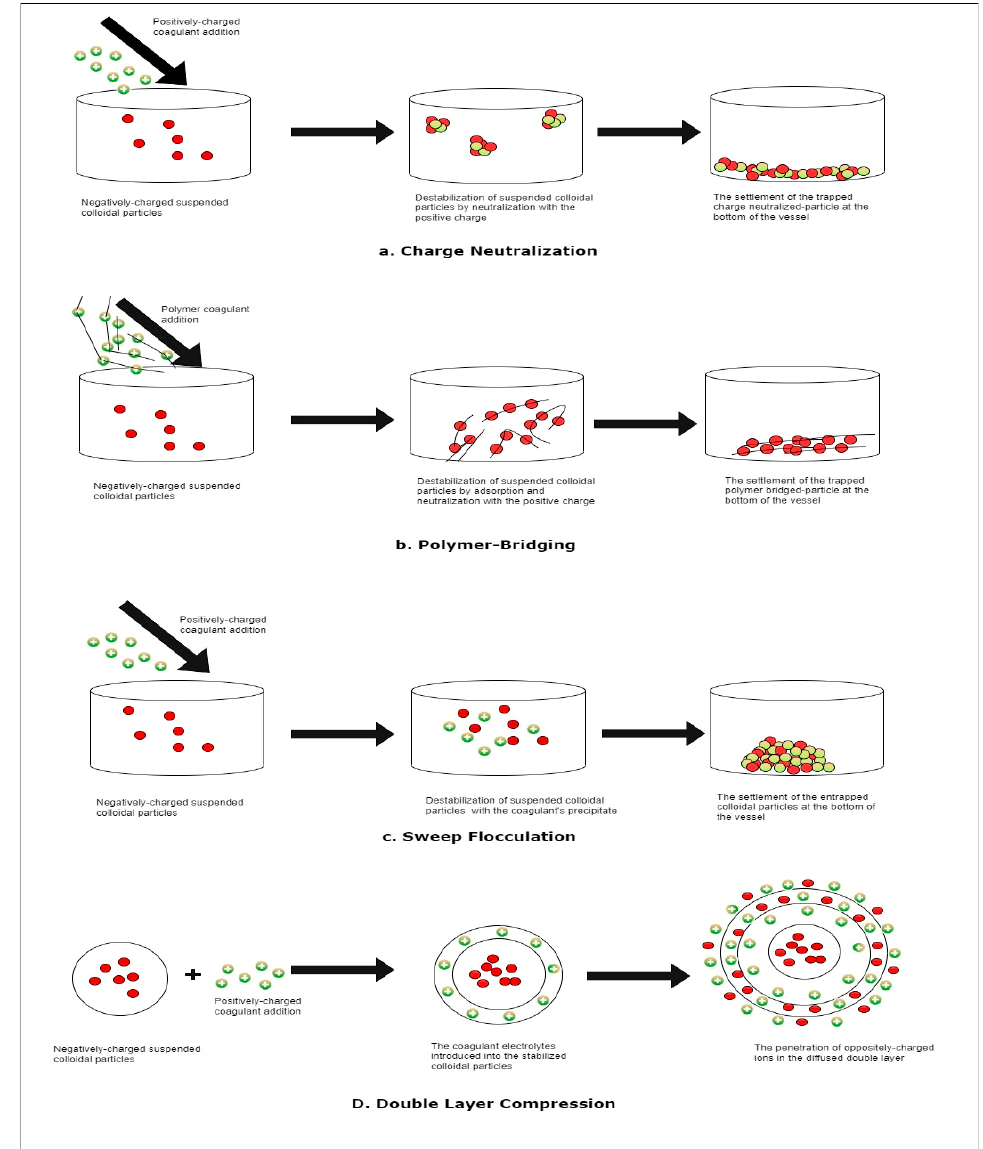
Figure 4. Schematic representation of the mechanisms involved in natural coagulation process.